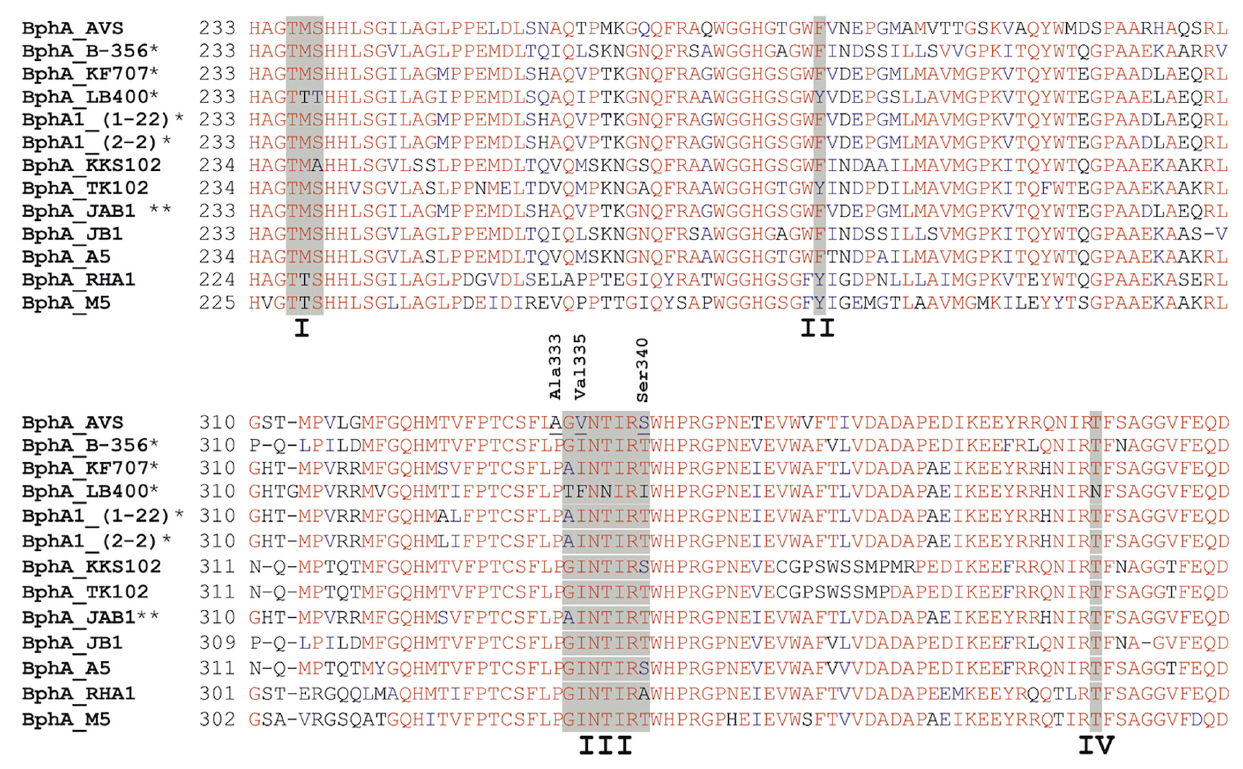
FIGURE 8 | Multiple sequence alignment of functionally characterized BphA protein sequences closely related to BphA_AVS. Regions I, II, III, and IV as discussed by Mondello et al. (1997) and Vézina et al. (2008) are highlighted with a gray background. The BphA_AVS residues Ala333 and Val335 discussed in the text are marked. Highly conserved regions are shown in red. Residues with greater than 50% identity are shown in blue. (*) Transformation of flavonoids by BPDO reported in the literature, (**) transformation of flavone and flavanone proven (Zubrova et al.,